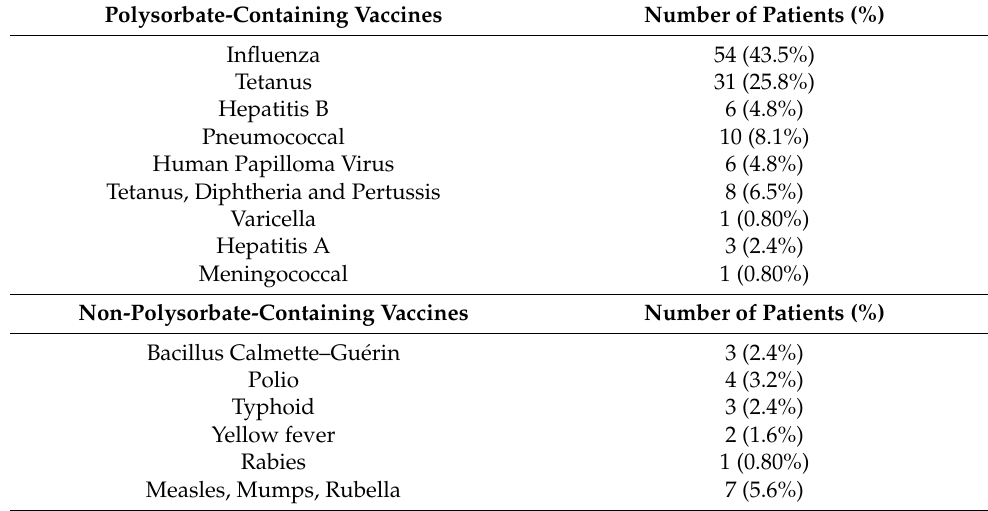
Table 2. Details of the type of vaccine allergies of the 124 patients in the SPT/IDT and DI